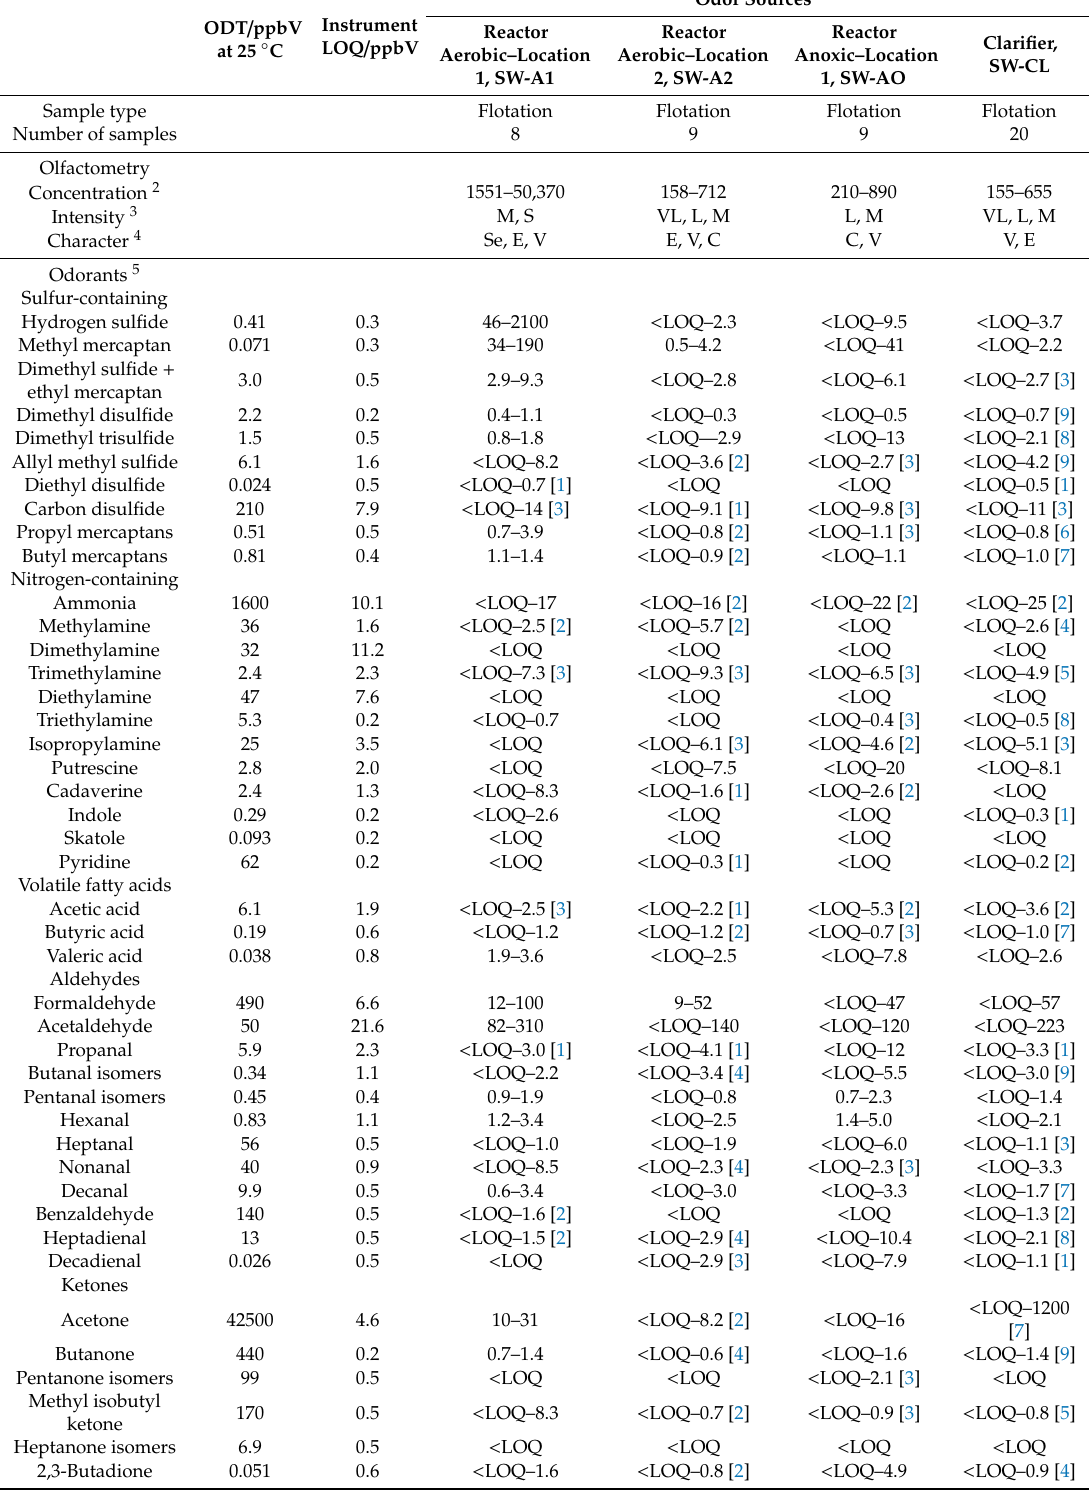
Table 6. Sensory data and SIFT-MS concentration data (in ppbV) for odor sources from secondary liquids treatment. The range of values for each source is shown. See the text and table footnotes for more